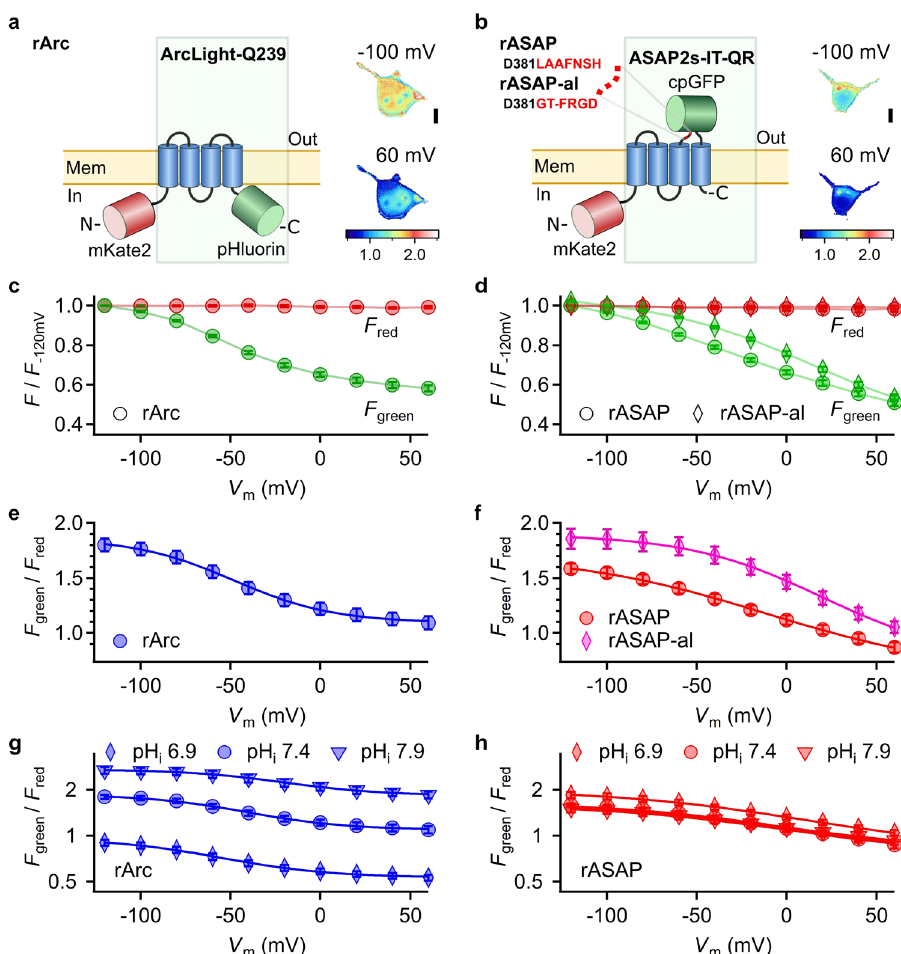
Fig. 1 Evaluation of ratiometric GEVIs based on ArcLight and ASAP. a , b Schematics of ratiometric rArcLight-Q239 (rArc) and ratiometric ASAP2s-I67T- Q397R (rASAP). rASAP and rASAP-al differ in the linker between the S3 transmembrane segment of the voltage-sensitive phosphatase and cpGFP as indicated. Pixel-by-pixel fl uorescence ratio ( F green / F red ) images of HEK293T cells expressing rArc ( a ) or rASAP ( b ) voltage-clamped to the indicated V m . Images were acquired with 470 nm (green) and 530 nm (red) excitation light (Supplementary Fig. 1). Calibration bar indicates F green / F red values. Scale bar, 10 µ m. c , d Normalized F green and F red signals of voltage-clamped cells with rArc, rASAP, or rASAP-al; n = 10 – 11. Straight lines connect data points for clarity. e , f F green / F red from fl uorescence data shown in ( c ) and ( d ) as a function of V m . The F green / F red signal was corrected for bleaching (Supplementary Fig. 1). Regions of interests (ROIs) for data extraction included the membrane areas only. g , h F green / F red as a function of voltage of cells expressing rArc or rASAP with intracellular solution adjusted to the indicated intracellular pH (pH i ). Data at pH i 7.4 are identical to data in ( e ) and ( f ), respectively; n = 7 – 11. Data are means ± sem. Smooth curves in e – h are the results of fi ts according to Eq. 1; for results see Supplementary